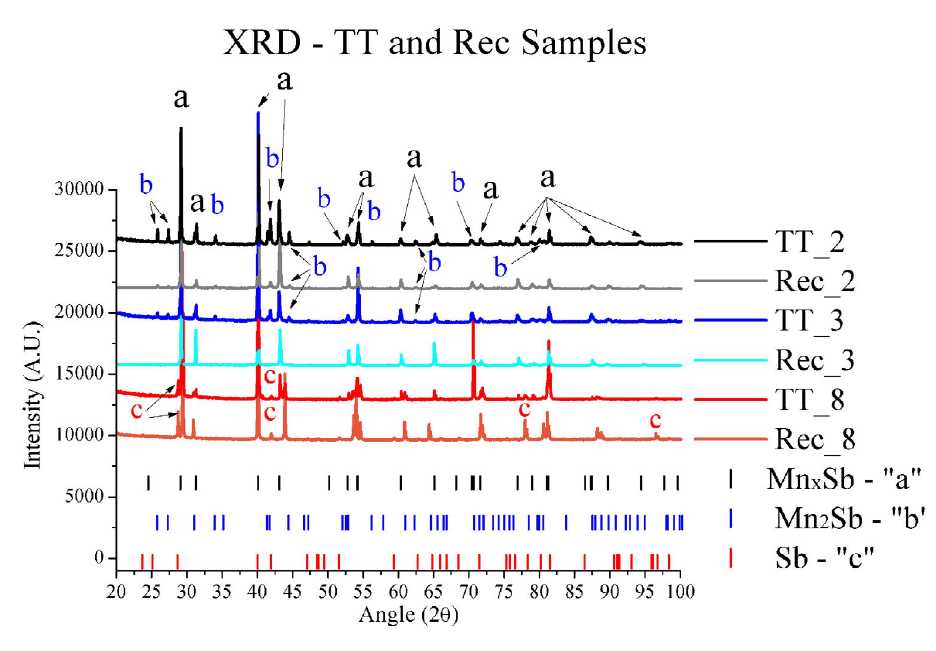
Figure 4. XRD Analysis, where 2 = 44%atSb, 3 = 45%atSb, 8 = 50%atSb on nominal stoichiometry.